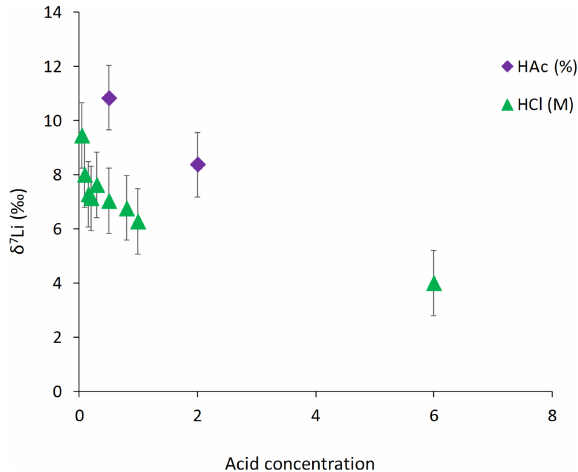
Figure 7. Lithium isotope composition of leaching solutions for experiments with HCl and HAc.